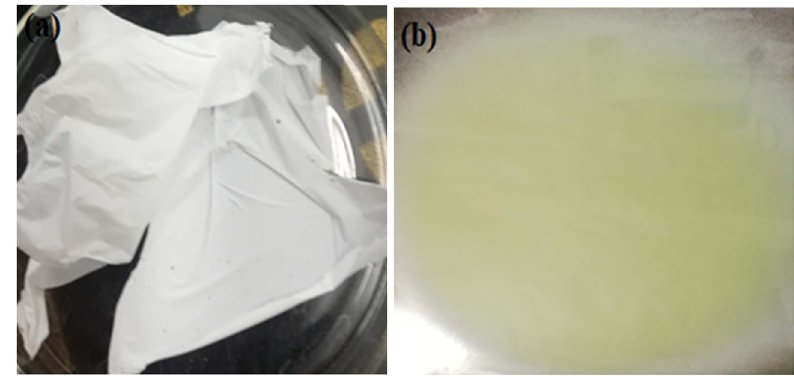
Figure 1: MMT - reinforced crosslinked PVA nano fi bers ( a ) and extract loaded nano fi bers ( b )